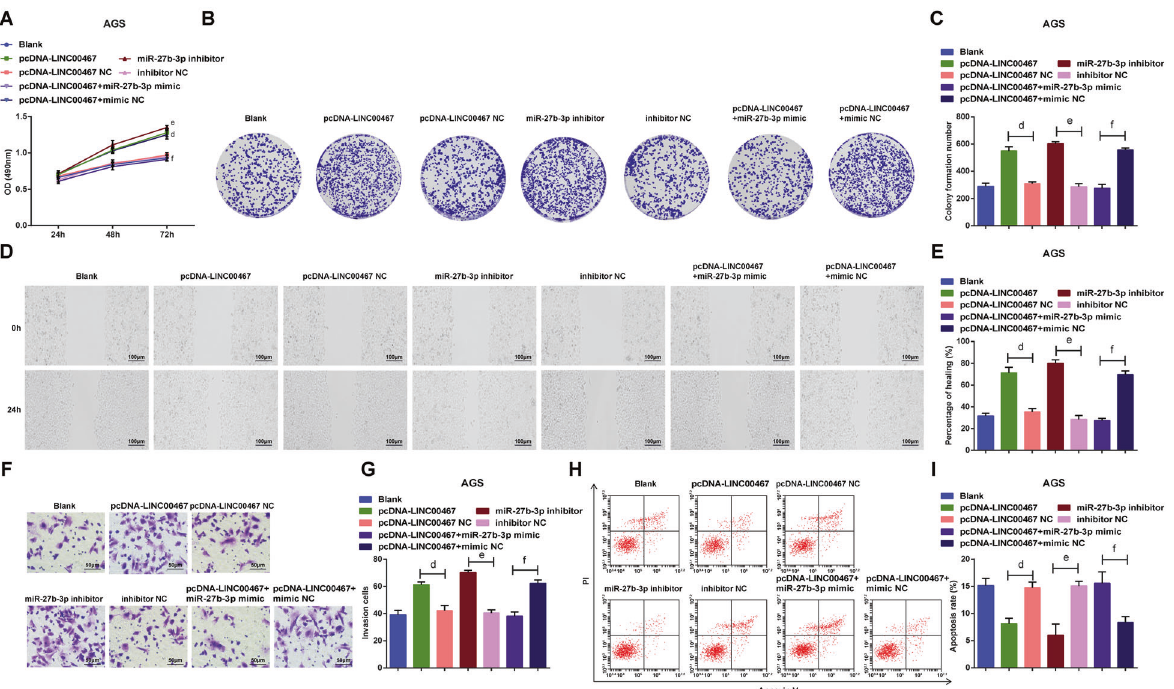
Fig. 4 Upregulation of LINC00467 or inhibition of miR-27b-3p promotes malignant phenotypes of GC cells. A AGS cell growth was measured by MTS colorimetry. B Colony formation ability of AGS cells was detected by colony formation assay. C number of colonies of AGS cells. D Migration ability of AGS cells was measured by scratch test. E comparison of healing rate of AGS cells among the groups. F Invasion ability of AGS cells was measured by Transwell assay. G comparison of invasive ability of AGS cells among the groups. H Apoptosis rate of AGS cells in each group. I Apoptosis of AGS cells was gauged by fl ow cytometry; d P < 0.05 vs the pcDNA-LINC00467 NC group, e P < 0.05 vs the inhibitor NC group, f P < 0.05 vs the pcDNA-LINC00467 + mimic NC group; N = 3; the measurement data were expressed as mean ± standard deviation.